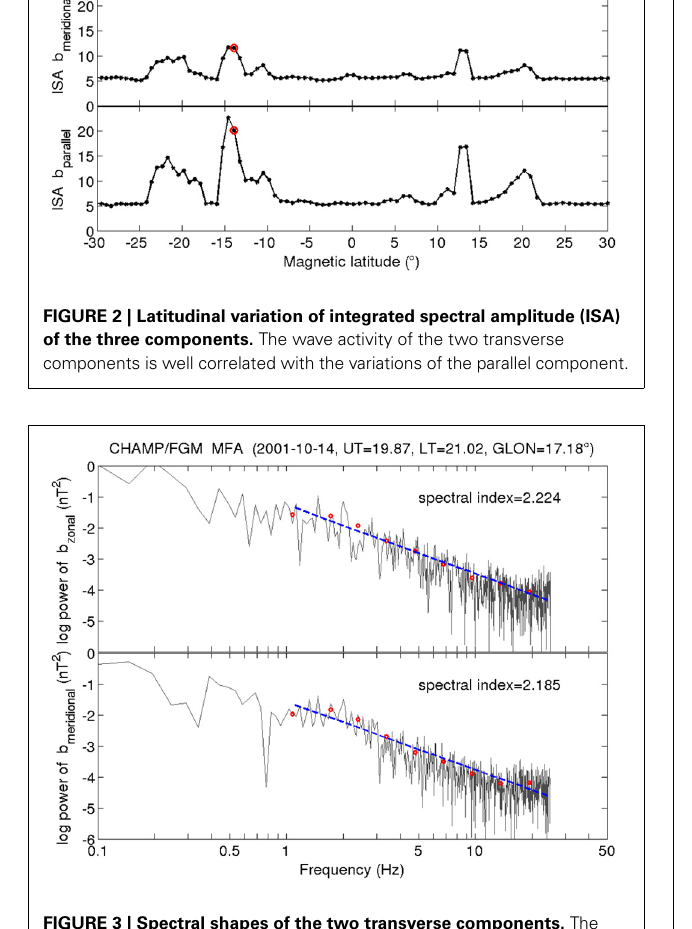
FIGURE 3 | Spectral shapes of the two transverse components. The spectral decay can be approximated by a power law (blue dashed line). The spectral indices derived for the two components are almost the same.